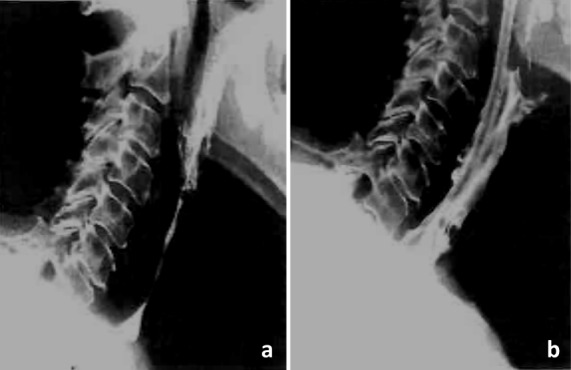
Laryngeal stenosis after laryngectomy and subsequent radiation: a – prior to surgery; b – skin-platysma-fascia flap [278].